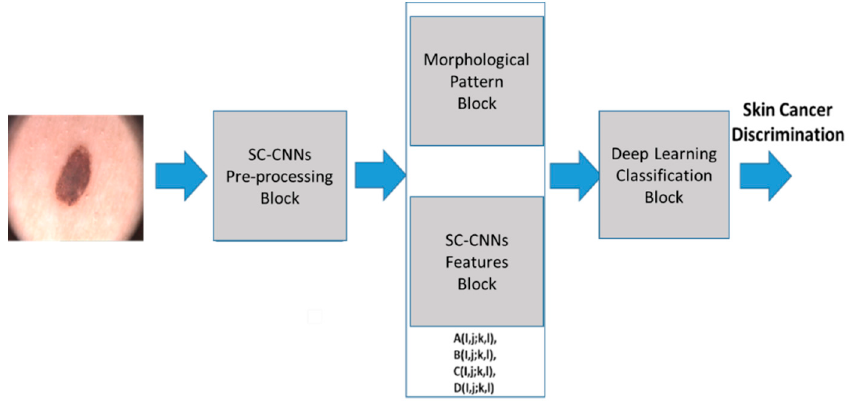
Figure 1. The proposed bio-inspired skin lesion discrimination pipeline.